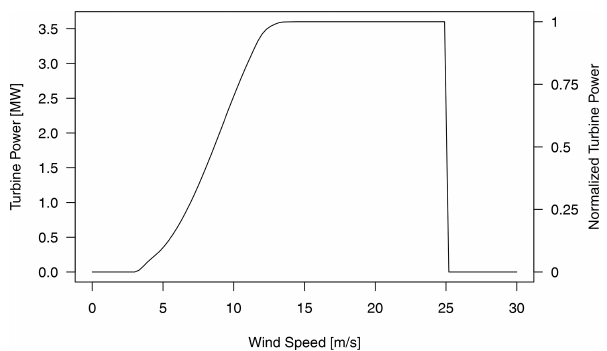
Figure 3. Theoretical power curve of a large offshore wind turbine.